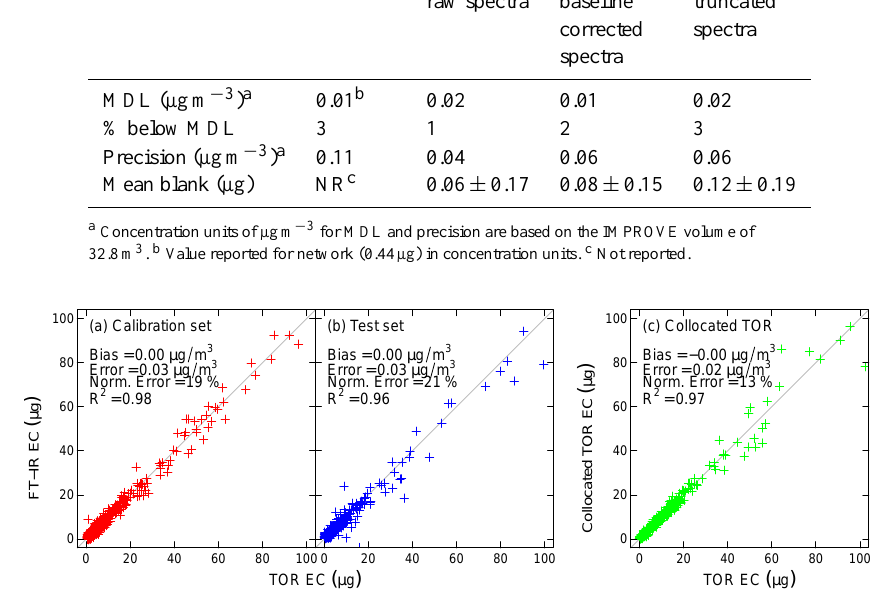
FT-IR methods than for TOR by about half. The mean pre- dicted value for the blanks filters (last row of Table 1) is less